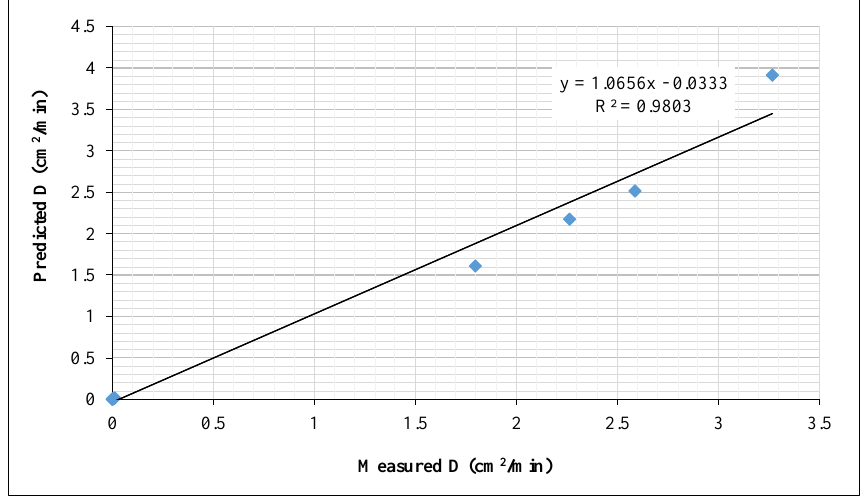
Figure1. Calibration graph showing predicted and measured of dispersion in soil.